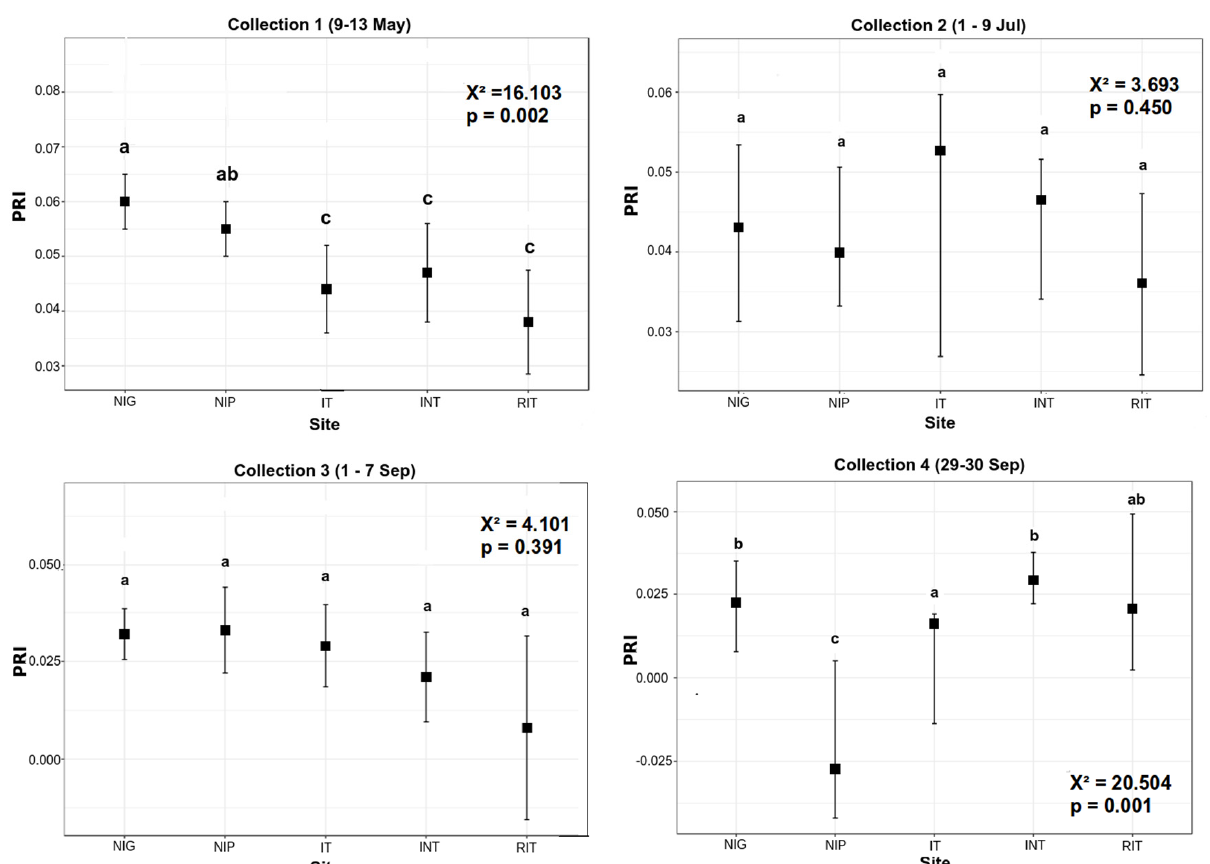
Figure 9. Kruskal–Wallis test results for PRI in 2018. Letters indicate groupings determined by the Conover–Iman test with Bonferroni adjustment. Codes for each site are given in Table 2. Whiskers indicate the range of the data. Note that data ranges were selected to show variation within the data sets, are not uniform between each panel of the diagram.